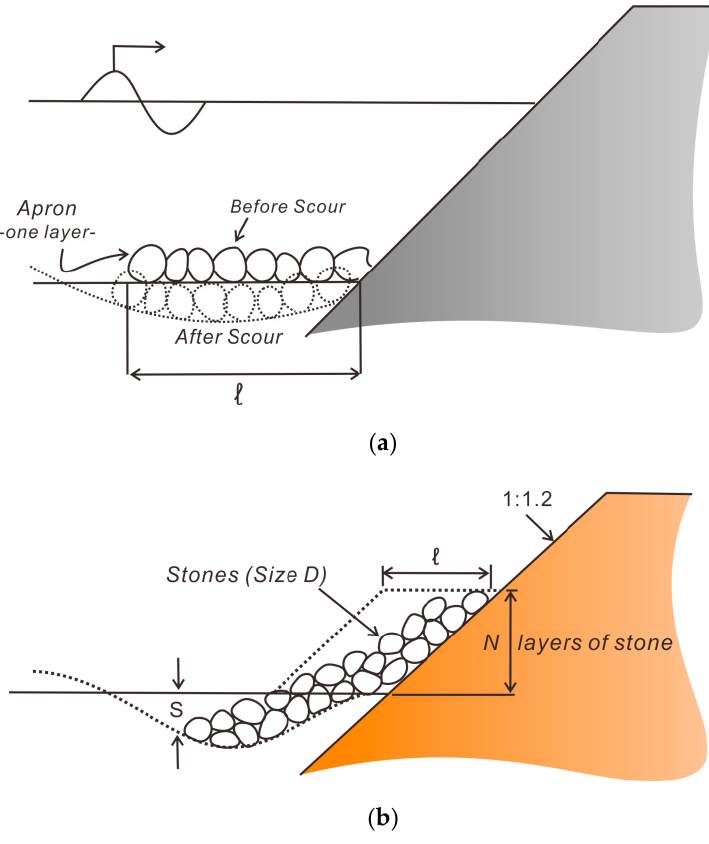
Figure 2. Schematic sketch of scour protection using rocks (a) Scour protection using one layer of rock (b) Scour protection using multiple layers of rock armor (reproduced from [9]).